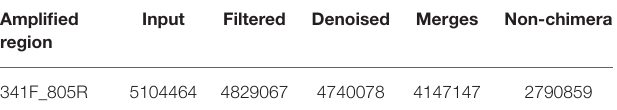
TABLE 3 | Summary of sequencing data in the dog gut microbiota. Amplified region